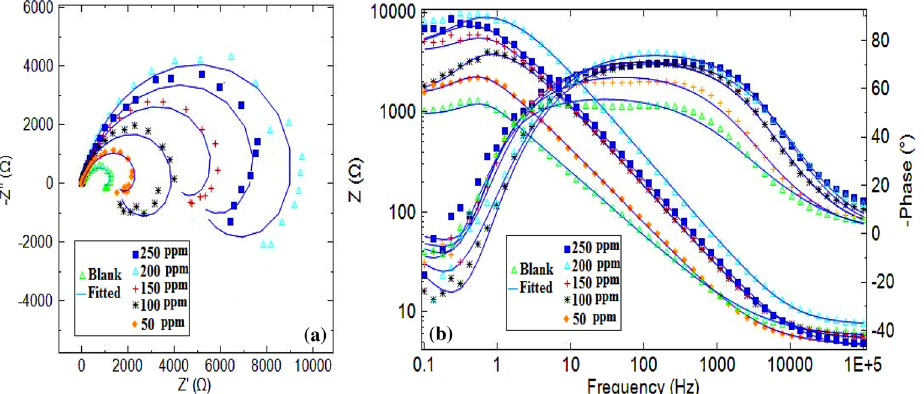
Figure 11. ( a ) The Nyquist and ( b ) Bode diagrams for Al alloy in corrosive media in the absent and present of RA/AgNPs.